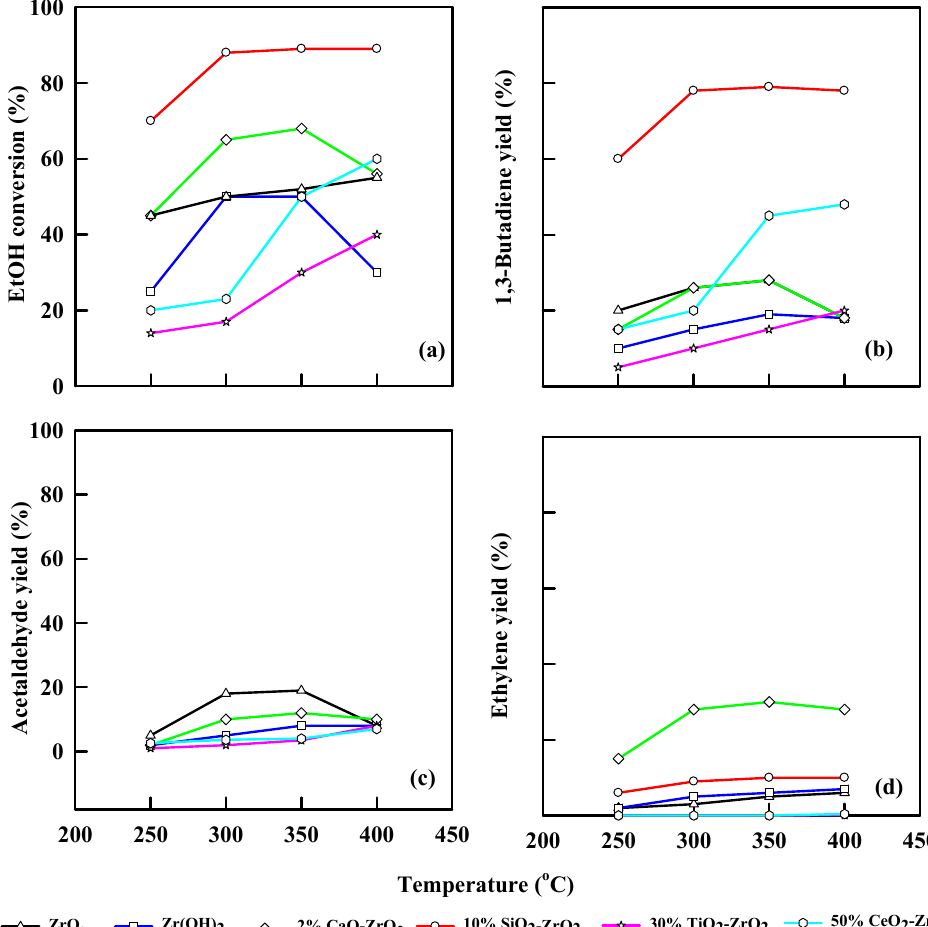
Figure 8. Plot of ethanol conversion ( a ), yields of 1,3-butadiene ( b ), acetaldehyde ( c ), and ethylene ( d ) vs. reaction temperature for different modified commercial catalysts. WHSV: 0.75 h − 1 , catalyst: 0.4 g, N 2 : 30 mL/min.